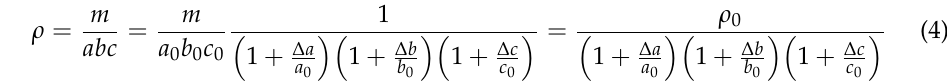
Figure 5. RT fluorescence lifetime fitted by exponential functions. Inset: the linear fitted lifetime with log (intensity) vs. time. (Source: [34], © 2015 Optica Publishing Group, Washington, DC, USA). 2.5. Continuous Laser Performance The effective gain cross-section ( σ g ) of Yb 3+ :ScBO 3 was determined using the follow- ing formula before the lasing experiments, as presented in Figure 6: 𝜎 𝑔 (𝜆) = 𝛽𝜎 𝑒𝑚 (𝜆) − (1 − 𝛽)𝜎 𝑎𝑏𝑠 (𝜆)